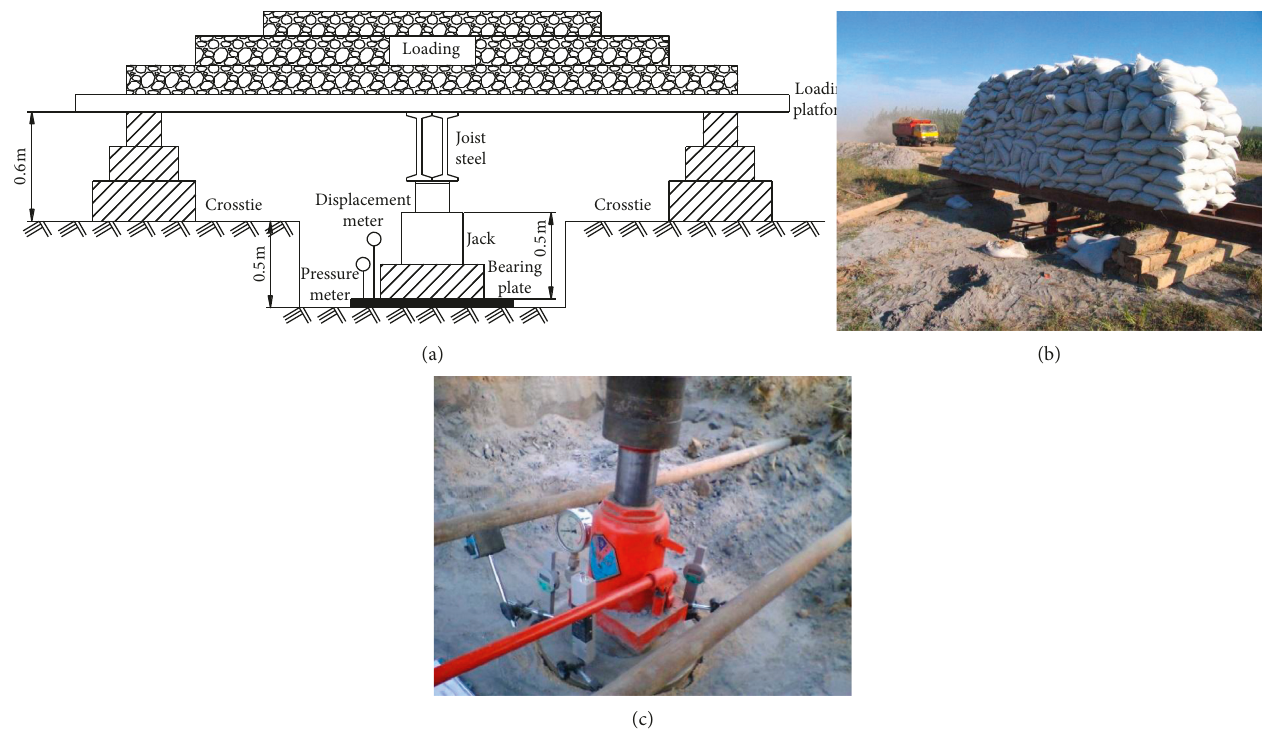
Figure 5: Arrangement of plate loading test.